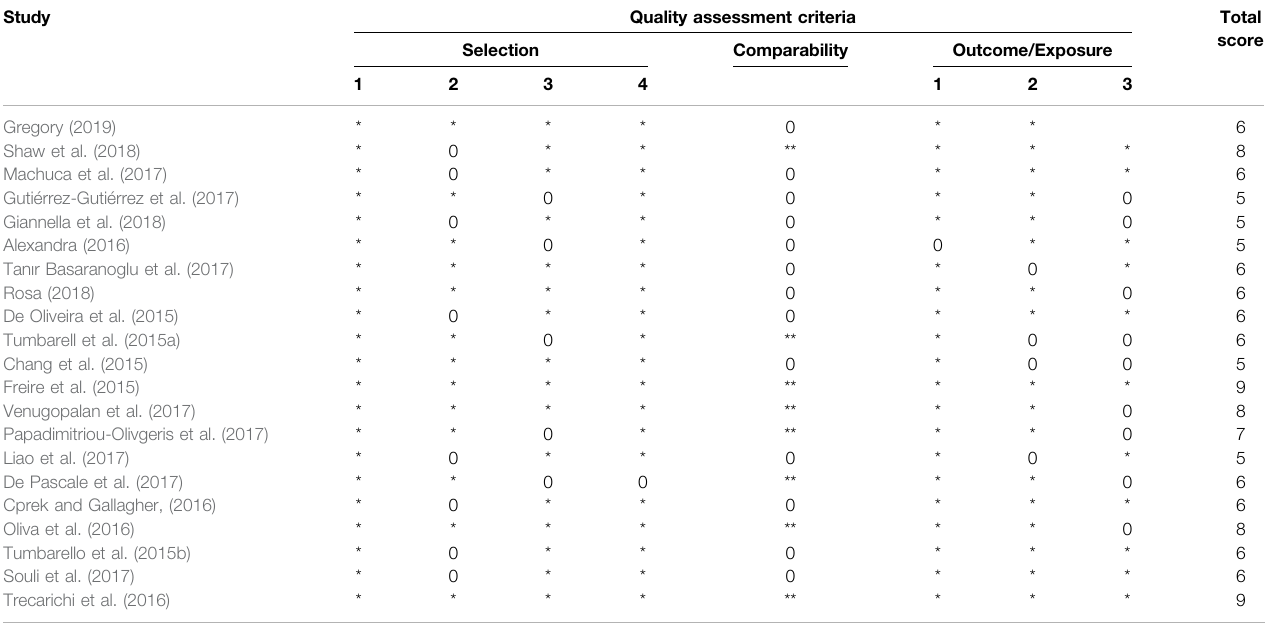
TABLE 2 | Study quality assessment based on Newcastle-Ottawa scale.